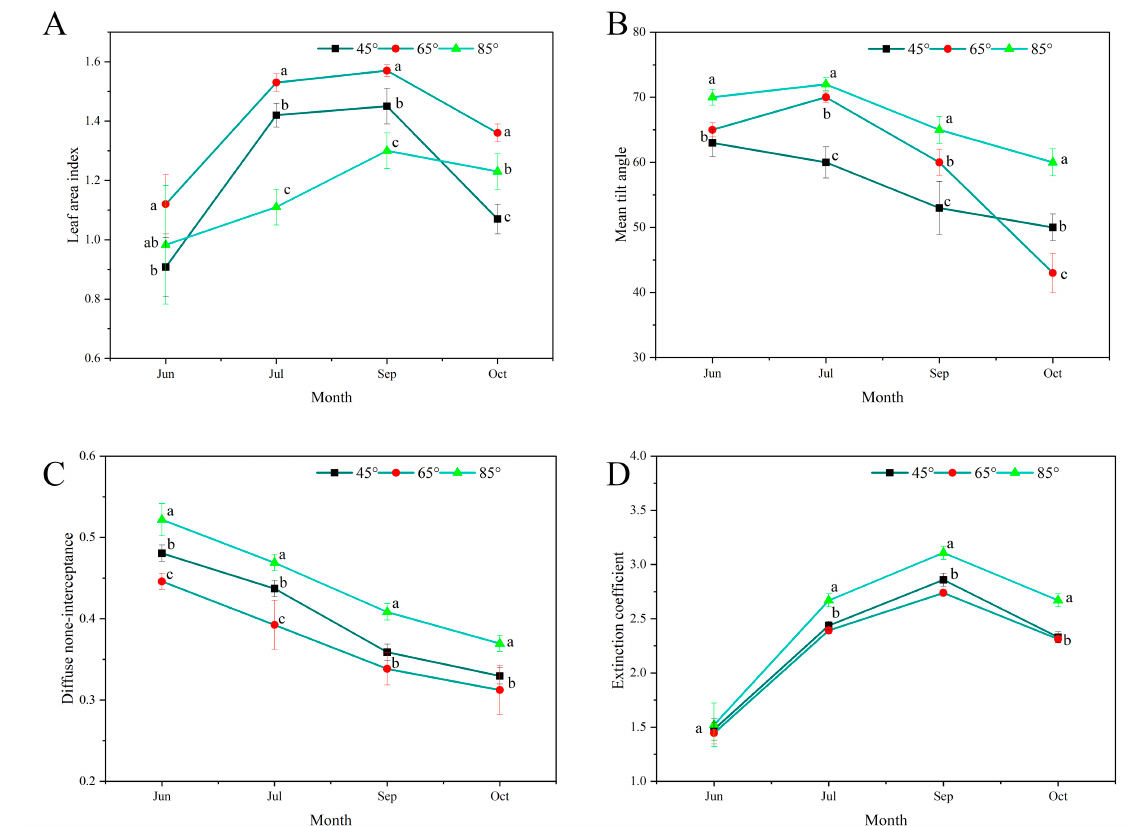
Figure 2. Differences in the canopy characteristics of peach trees with different main branch open- Figure 2. Di ff erences in the canopy characteristics of peach trees with di ff erent main branch opening ing angles. ( A ) Leaf area index; ( B ) mean tilt angle; ( C ) diffuse non-interceptance; ( D ) extinction angles. ( A ) Leaf area index; ( B ) mean tilt angle; ( C ) di ff use non-interceptance; ( D ) extinction coe ffi - coefficient. Within the same period, means followed by different letters are significantly different cient. Within the same period, means followed by di ff erent le tt ers are signi fi cantly di ff erent ( p < ( p < 0.05). 0.05).